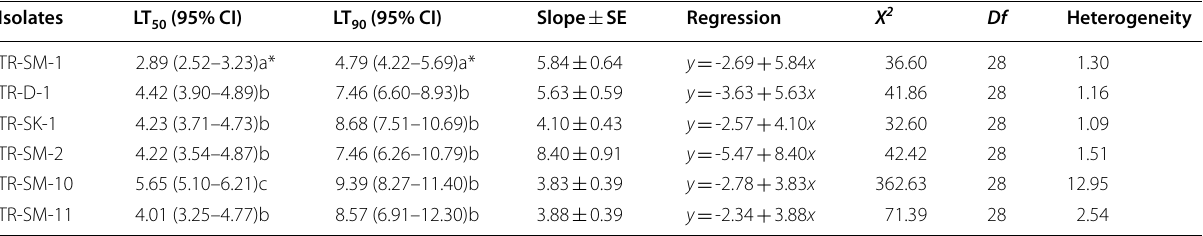
0.05 ≤ 10 8 conidia ml − 1 ×